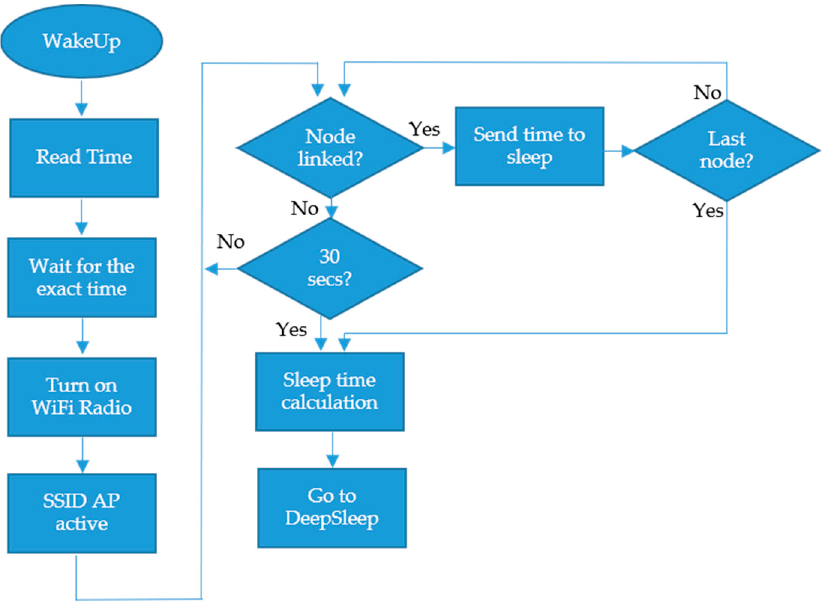
Figure 9. Execution diagram of the time-synchronizing procedure.